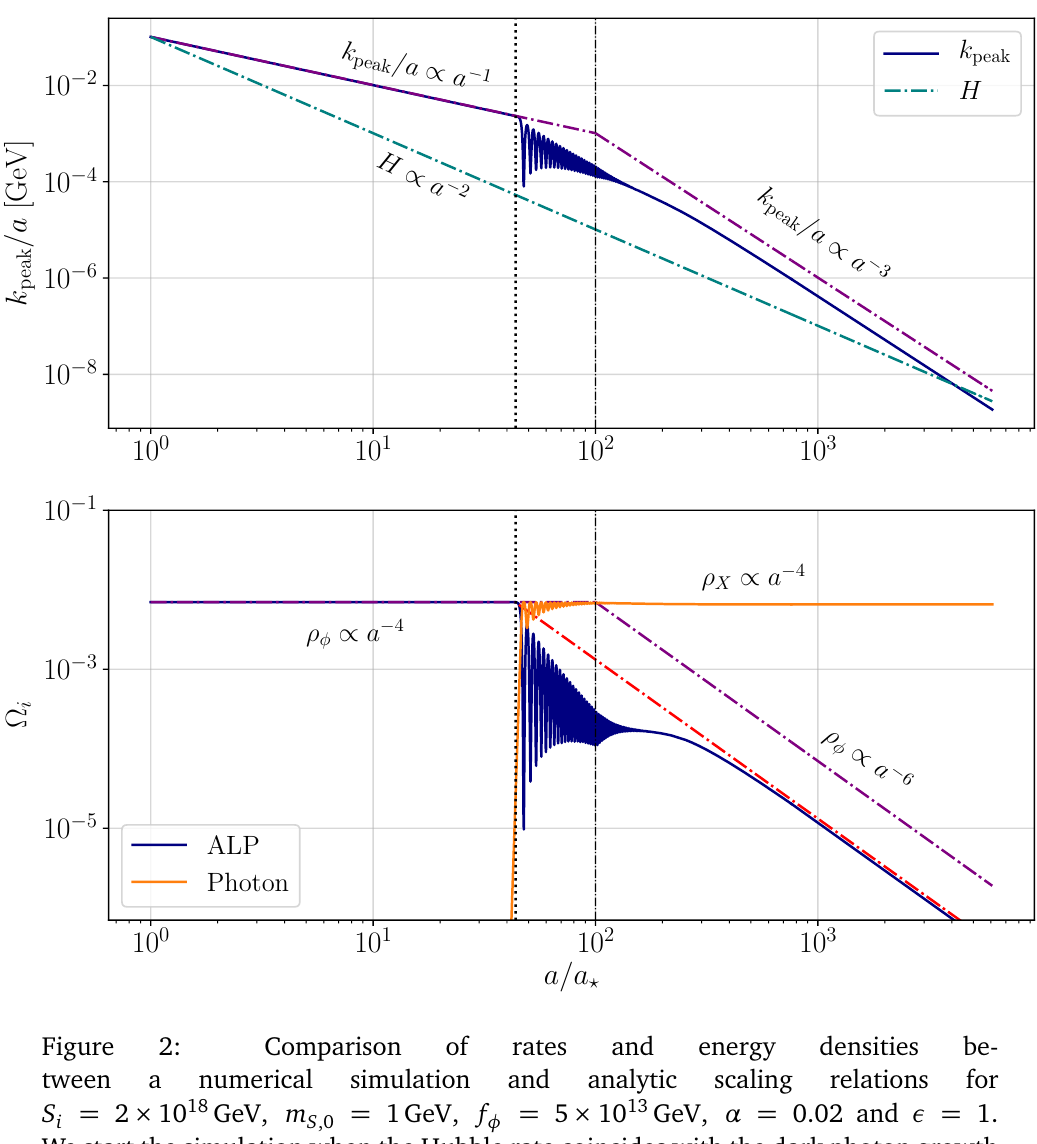
2: Comparison of rates and energy densities be- tween a numerical simulation and analytic scaling relations